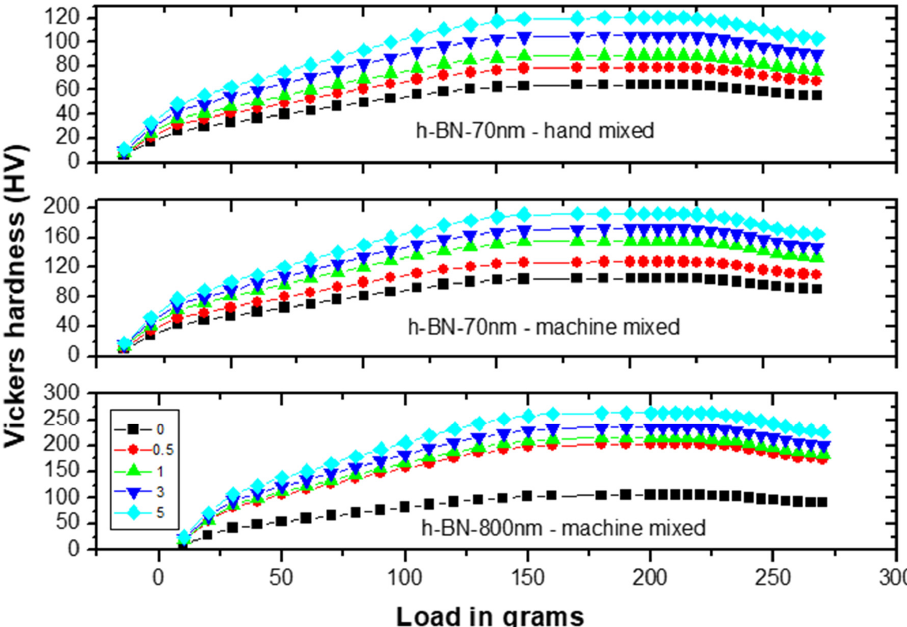
Figure 8. Vickers hardness (VH) measurements versus load on specimens made by hand and ultrasonic mixing methods for 70 nm and 800 nm h-BN reinforcement with different concentrations.